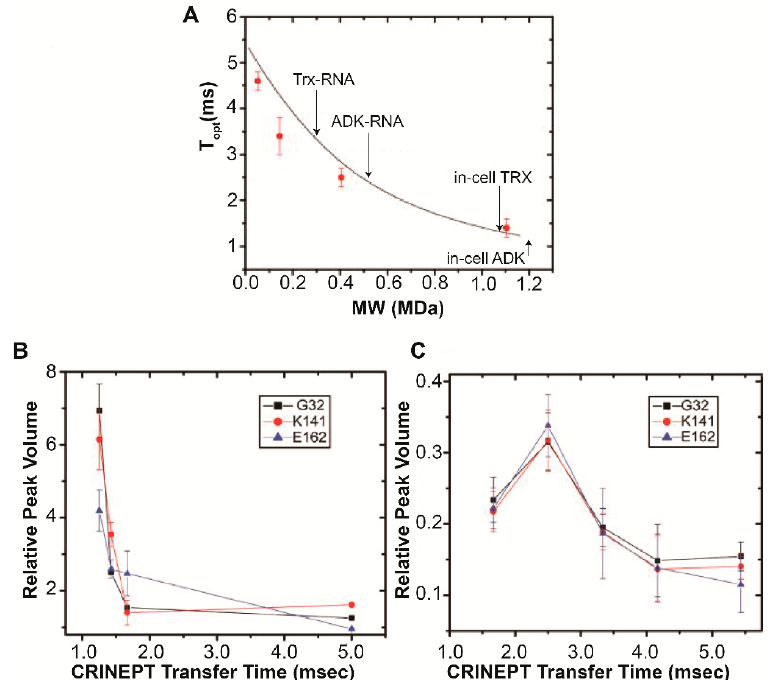
Figure 3. Optimizing the CRINEPT transfer delay time yields in-cell target protein apparent molecular weights. ( A ) The dependence of T opt on the apparent in-cell molecular weight, MW app at 700 MHz. T opt was experimentally